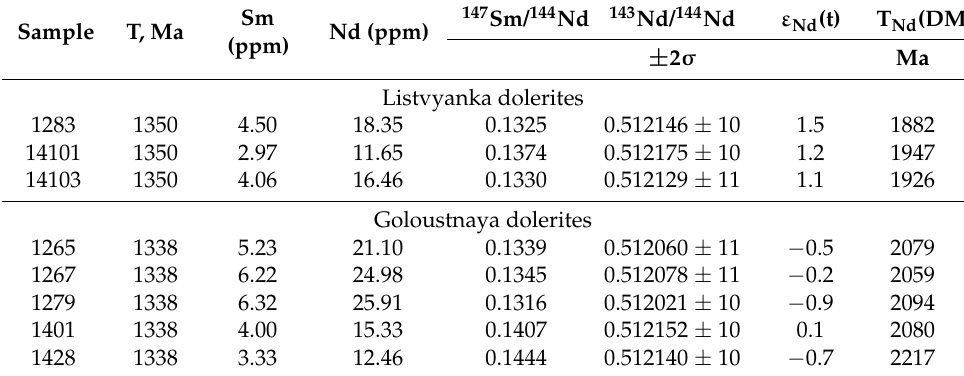
Table 2. Sm–Nd isotopic data for the Listvyanka and Goloustnaya